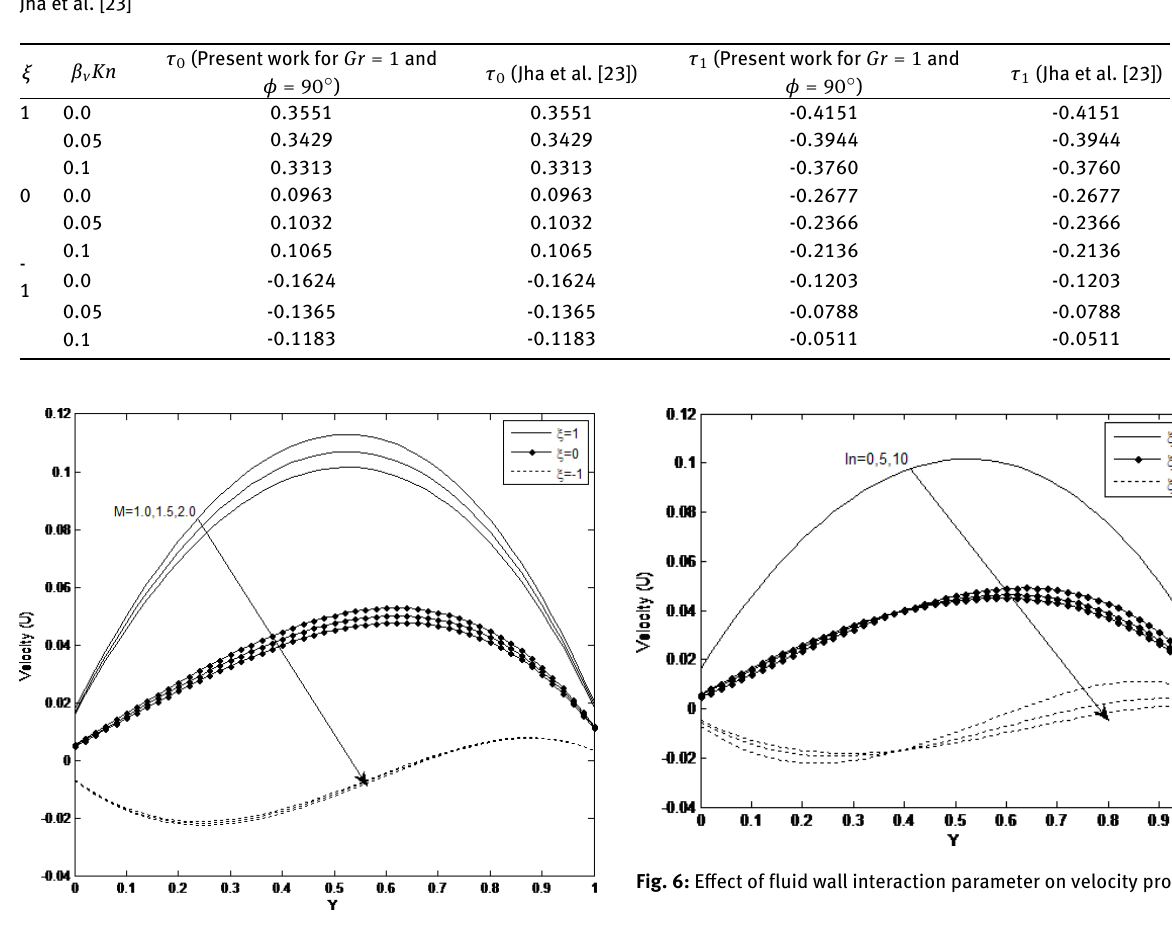
Table 1: Comparison of the numerical values of the skin friction at the micro-porous-channel walls (for Gr = 1 and ϕ = 90 ∘ ) with the work of